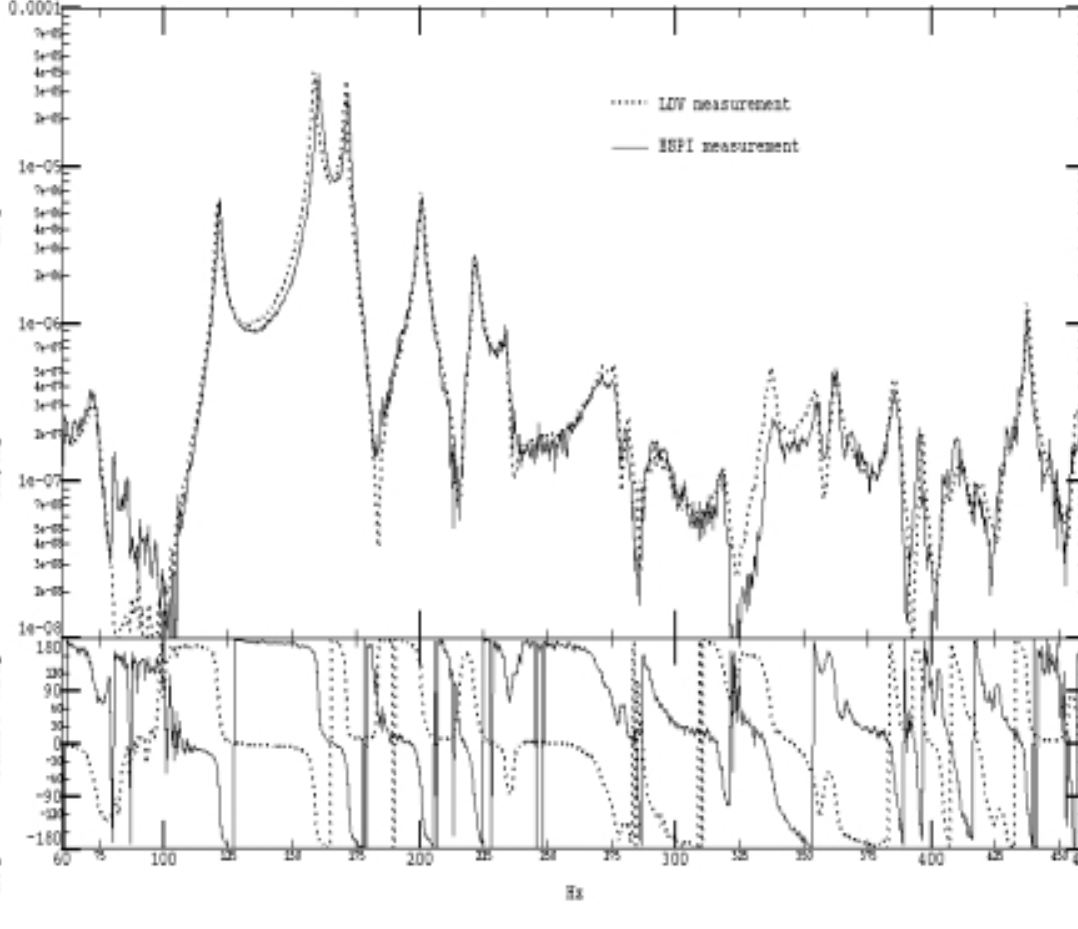
Fig. 8. FRF of a high response point measured with ESPI and LDV (dotted